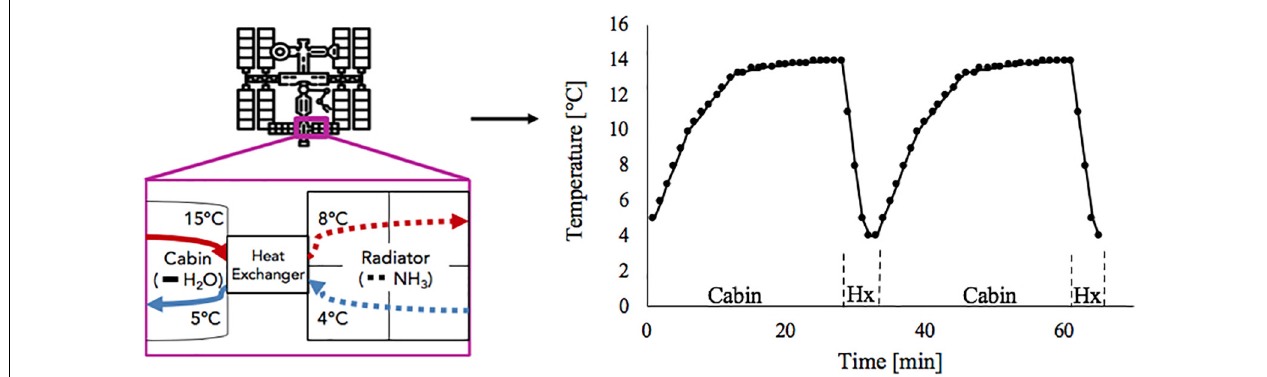
FIGURE 1 | Absorption of cabin heat and heat exchange between low temperature loop and ammonia radiator ( left ) results in temperature cycles in low temperature loop water as it flows between cabin and heat exchanger ( right ).